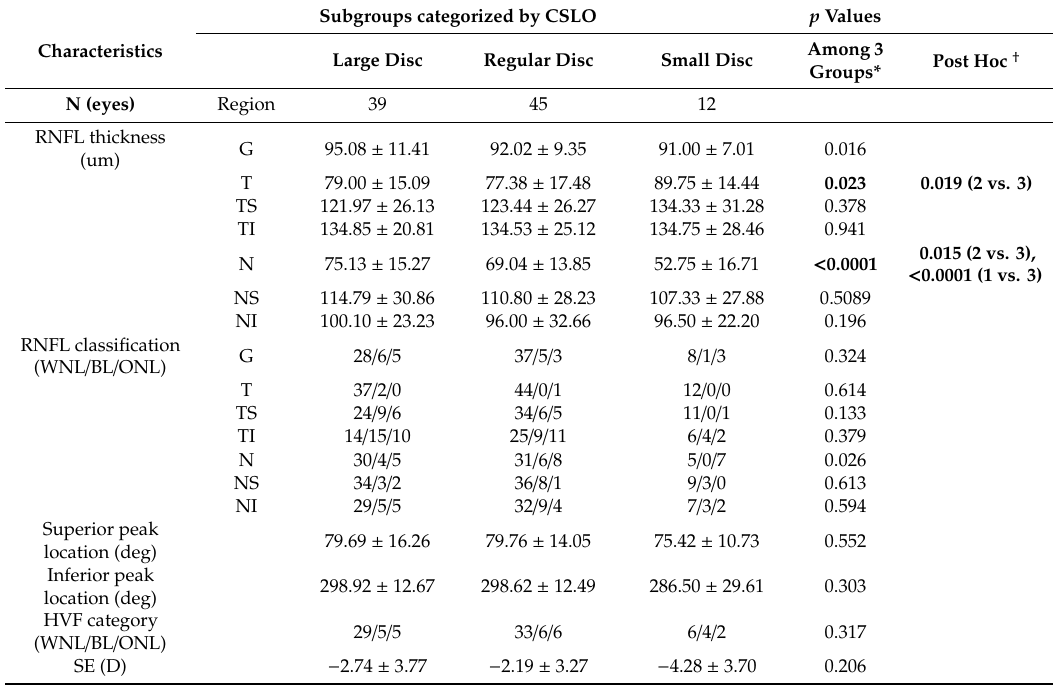
Table 4. Retinal nerve fiber layer according to optic disc